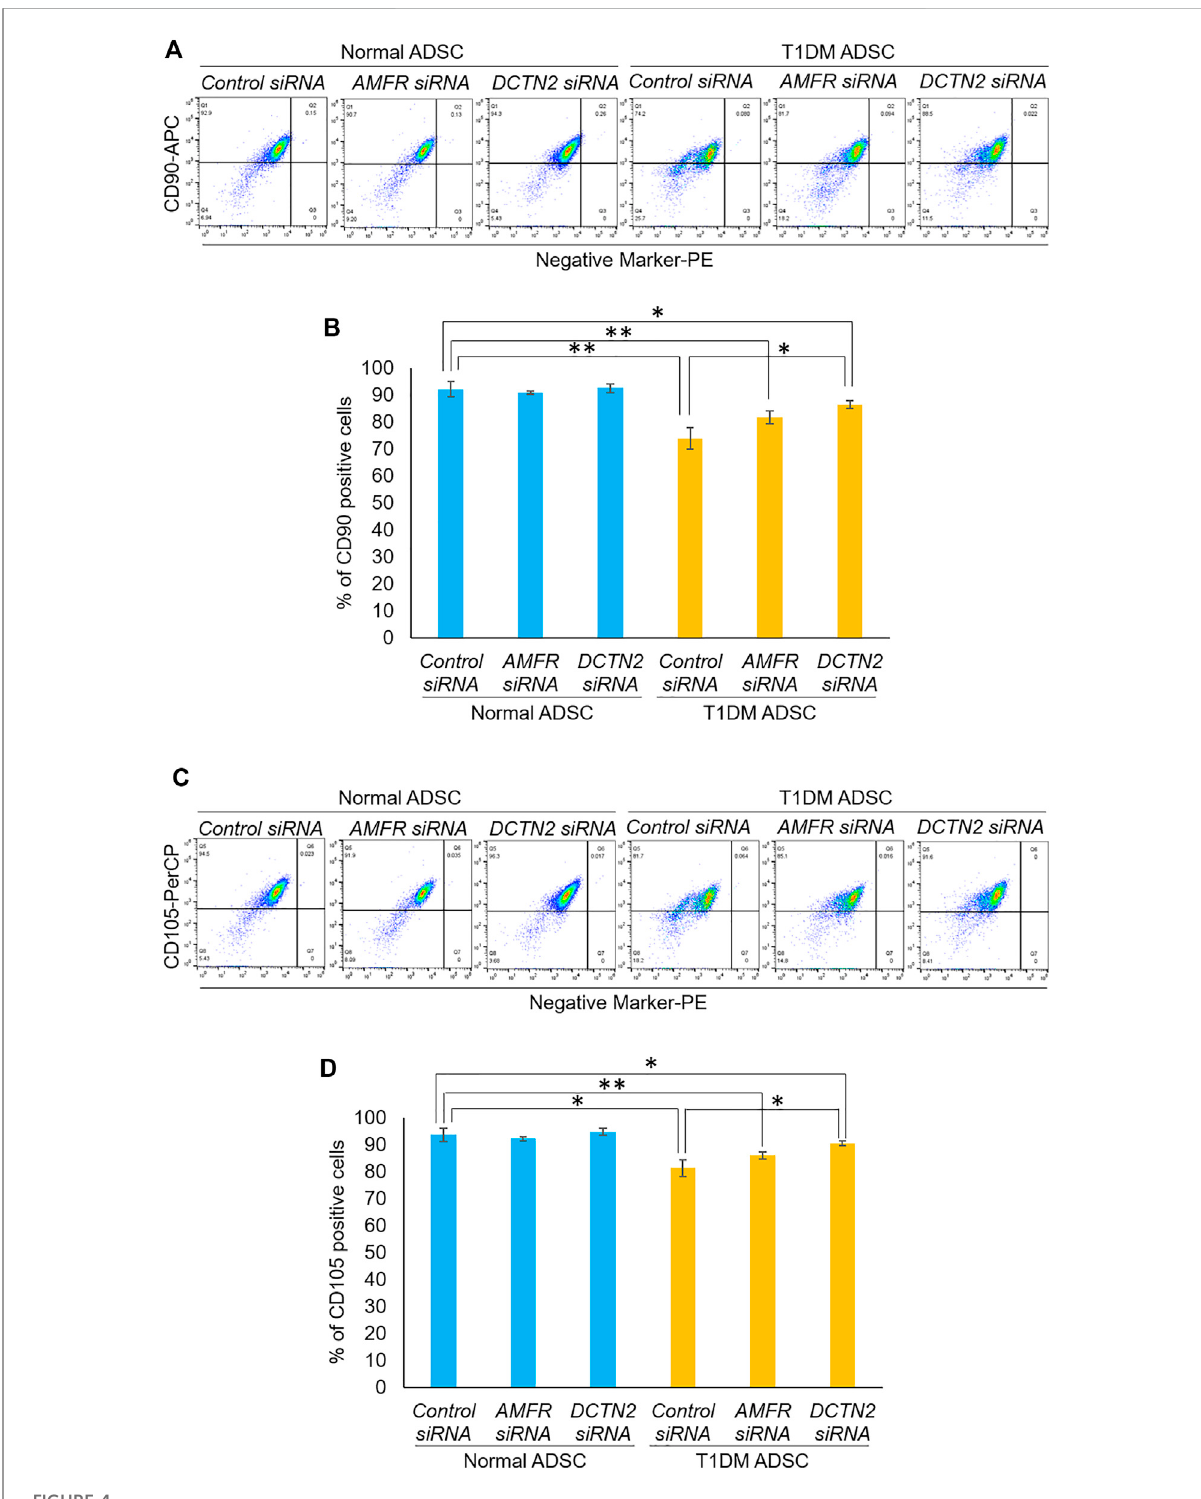
FIGURE 4 Evaluationofstemnessonhumanadiposetissue-derivedmesenchymalstemcells.Effectof AMFR and DCTN2 geneknockdownonthepositive rateofstemcellmarkersby fl owcytometry. (A) DistributionofCD90,amarkerofADSCsinnormalADSCsandT1DMADSCs. (B) Quantitativeanalysis of the percentage of CD90 positive cells. The p -values were 0.5779 (Normal ADSCs Control siRNA vs. Normal ADSCs AMFR siRNA), 0.8471 (Normal ADSCsControlsiRNAvs.NormalADSCs DCTN2 siRNA),0.0692(T1DMADSCsControlsiRNAvs.T1DMADSCs AMFR siRNA),0.013(T1DMADSCs